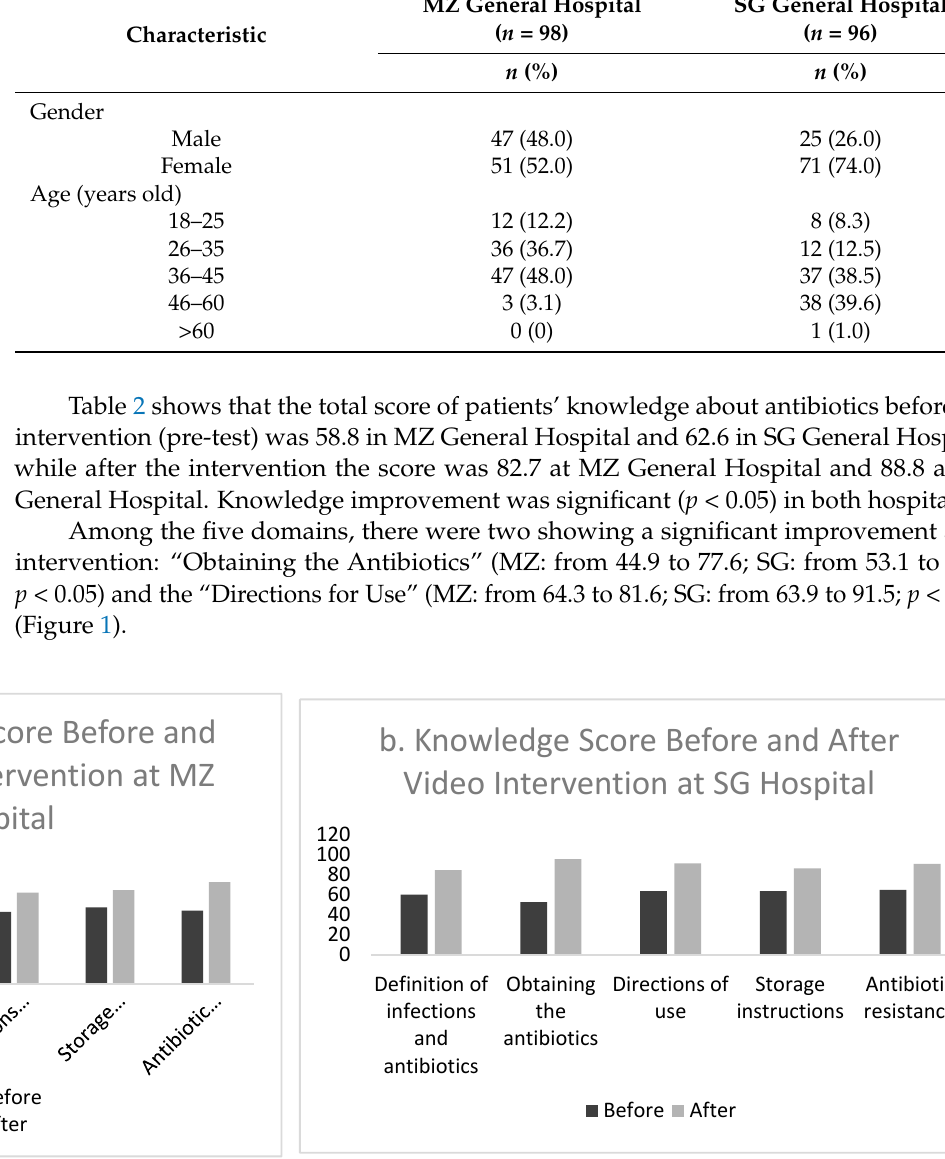
Figure 1. ( a ) Score of patient’s knowledge (%) before and after video intervention at ( a ) MZ General Hospital, and ( b ), SG General Hospital.